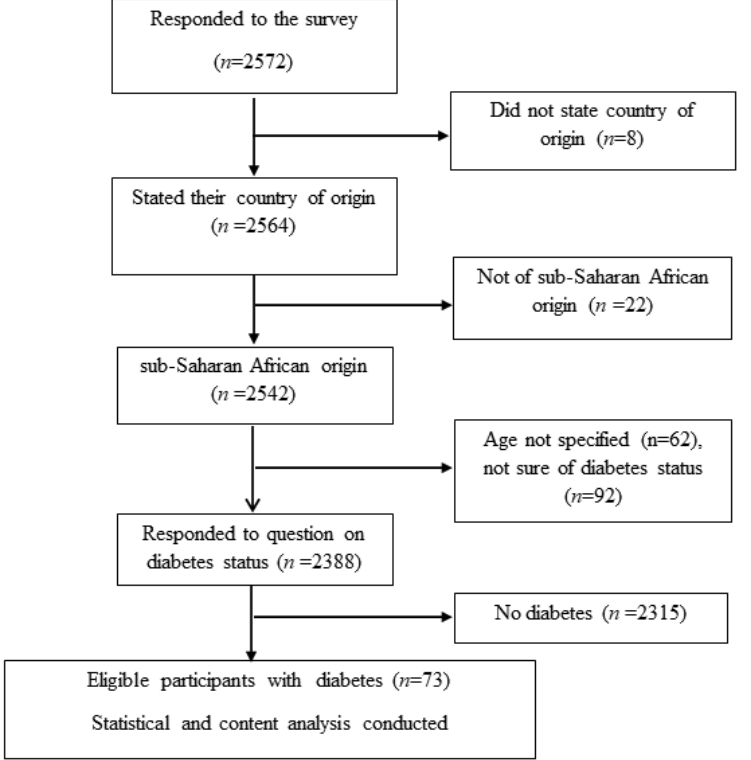
Figure 1. Flowchart of study participants.